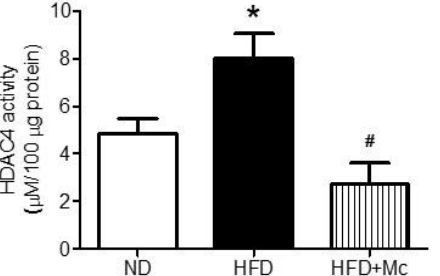
Figure 2. Maternal HFD increased nuclear histone deacetylase 4 (HDAC4) activity in the hippocampus of female o ff spring at 12 weeks old. Values were mean ± SEM. ND: n = 12; HFD: n = 12; HFD + Mc: n = 6. * p < 0.05 indicates significant di ff erences from the ND group and # p < 0.05 indicates significant di ff erences from the HFD group using a post-hoc Tukey’s multiple range test. ND: female o ff spring exposed to a maternal normal diet; HFD: female o ff spring exposed to a maternal high-fructose diet; Mc-1568 (Mc), class II HDAC inhibitor, 5 µ M by icv infusion for 4 weeks.